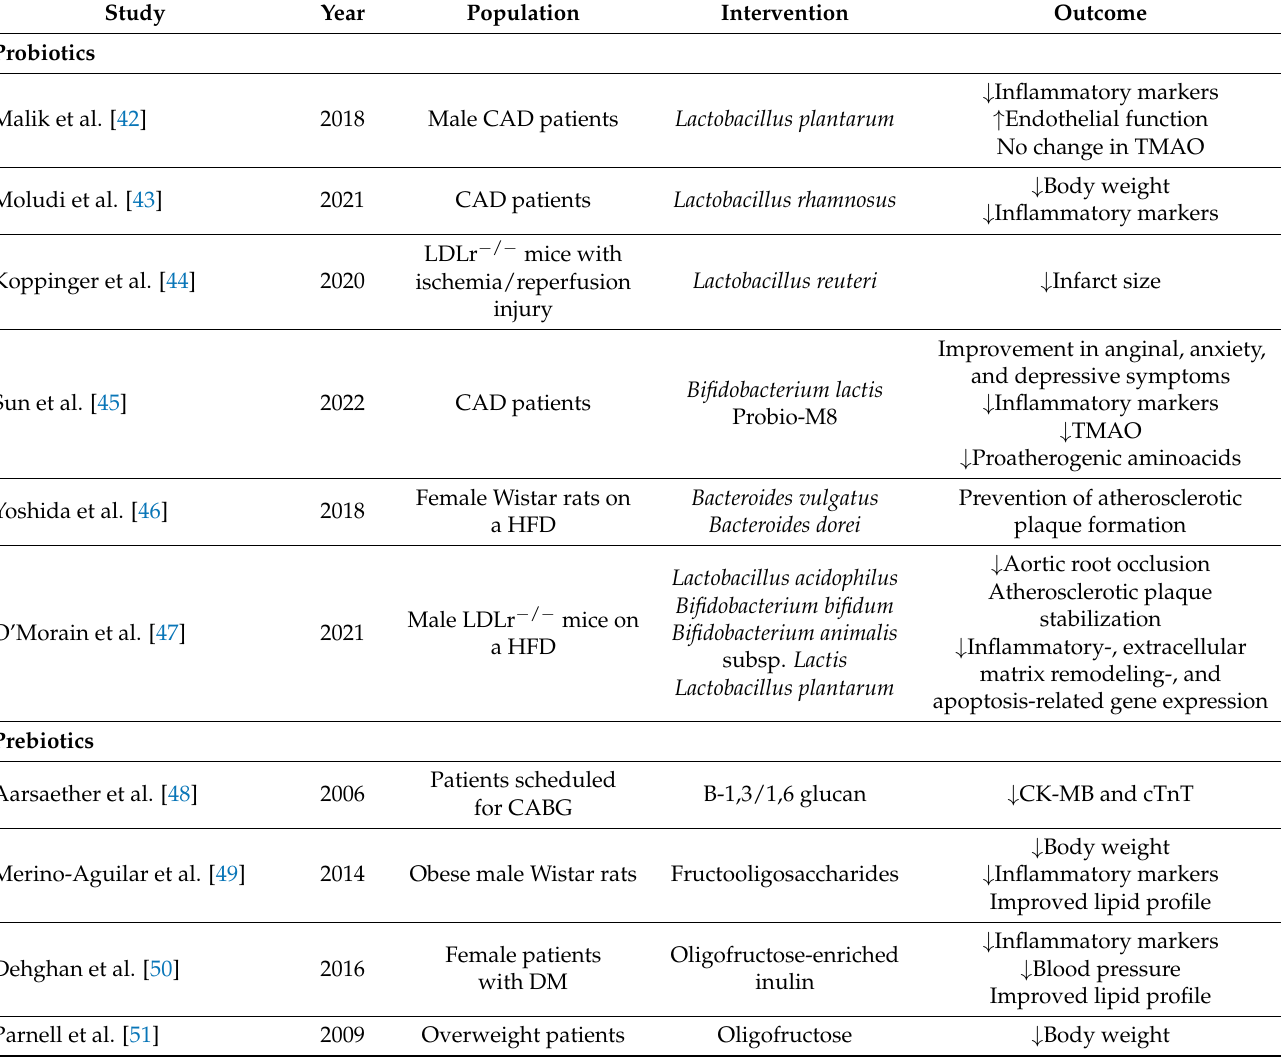
Table 1. Selected preclinical and clinical studies of gut microbiome modulation demonstrating the effect of interventions in experimental, surrogate, or clinical markers of